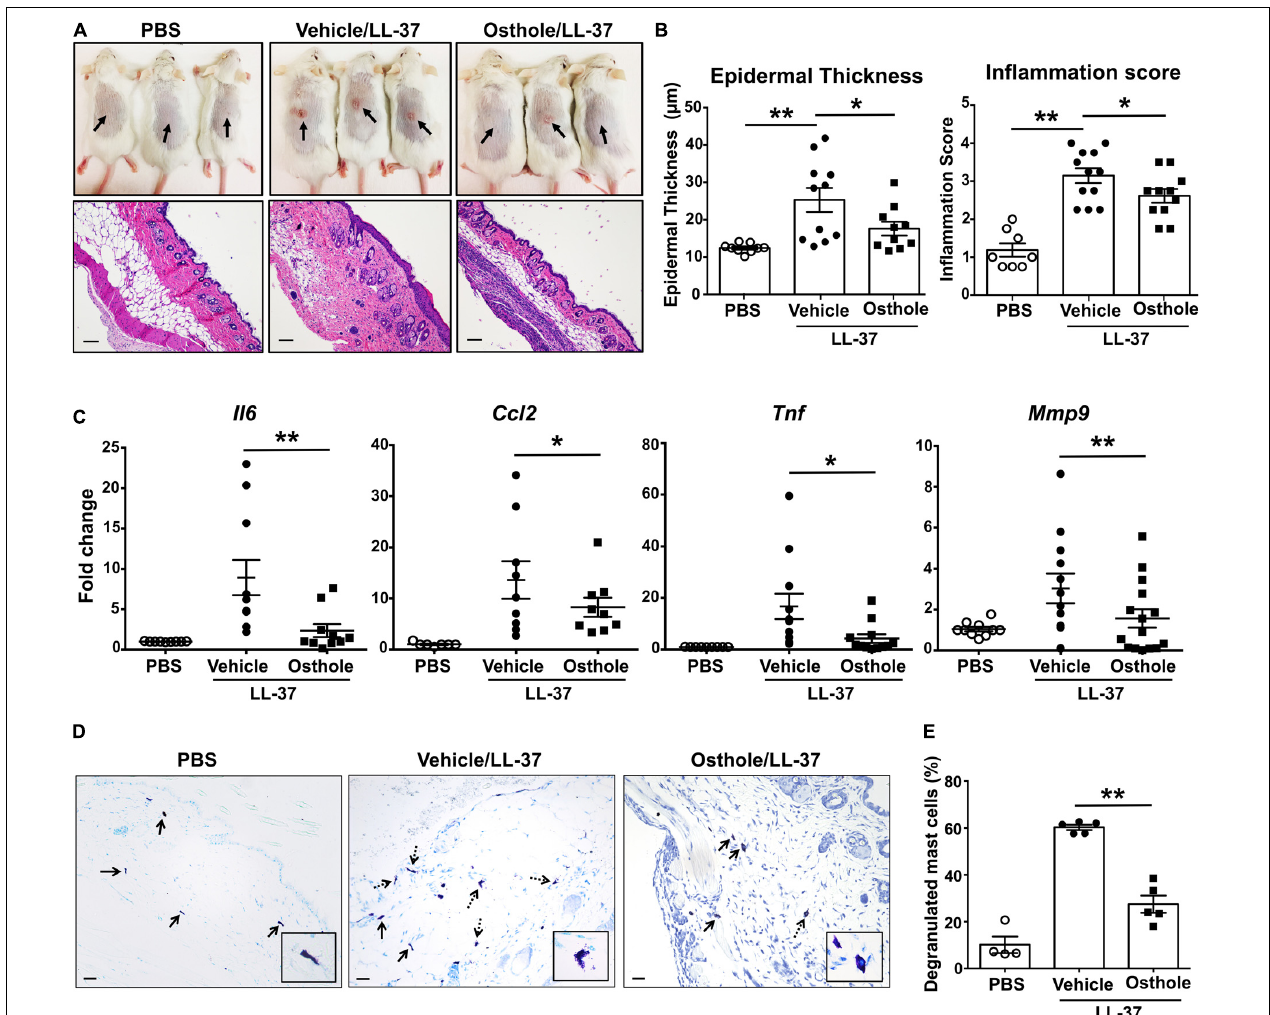
FIGURE 6 | Osthole prevents the development of LL-37-induced rosacea in mice. Vehicle- (0.2% DMSO in PBS, Vehicle/LL-37) or osthole- (Osthole/LL-37) treated Balb/c mice were injected with LL-37 into the dorsal skin (arrows) twice daily for 2 consecutive days. Mice that only received PBS on the dorsal skin were used as control. (A) Representative pictures of the dorsal skin (top panels) and H&E stained skin sections (bottom panels) of mice from different cohorts are shown. Scale bar = 100 µ m. (B) Graphs represent inflammation scores and epidermal thickness of the H&E stained skin sections. (C) mRNA expression of selected gene targets from the excised skin was analyzed by real-time PCR. Values are plotted as fold change (2 - (cid:49)(cid:49) Ct ) normalized to GAPDH levels. (D) The paraffin embedded skin sections from different cohorts of mice were stained with toludine blue to detect mast cells. Representiative pictures of the skin sections are shown. Bold arrows indicate intact mast cells whereas dotted arrows represent degranulated mast cells. The inset figure is an enlarged image of the mast cell(s) shown in the pictures. Scale bar = 100 µ m. (E) Graph shows the percentage of degranulated mast cells in the skin tissue of different cohorts of mice. Data are mean ± SE. from n = 4–15 mice/group. Statistical significance was determined by unpaired Student’s t -test comparing the vehicle vs. osthole treated groups * p < 0.05 and ** p <